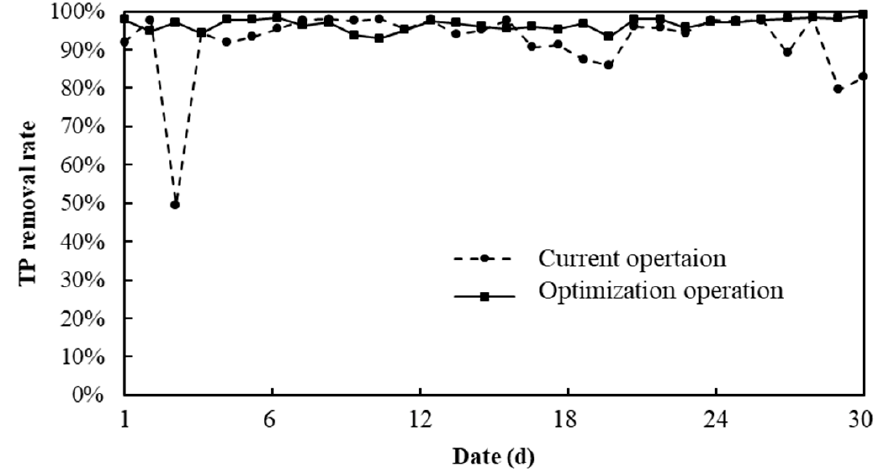
Figure 18. TP removal in the CAST process via optimization.